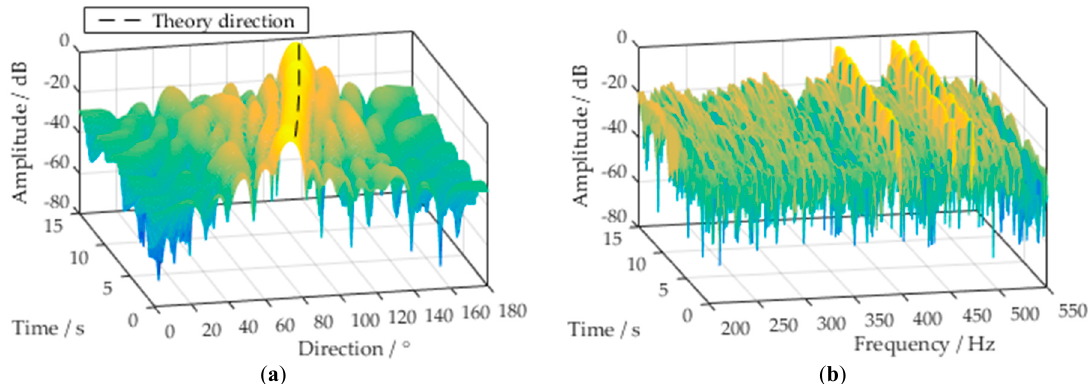
Figure 8. Beam response of the SBB: ( a ) Time-space response at tonal frequency; ( b ) Time-frequency response at target direction.